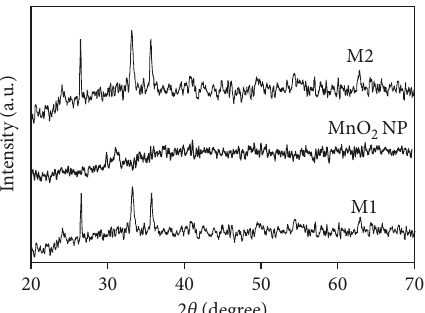
Figure 3: Powder X-ray diffraction pattern of M1, MnO M2 samples.